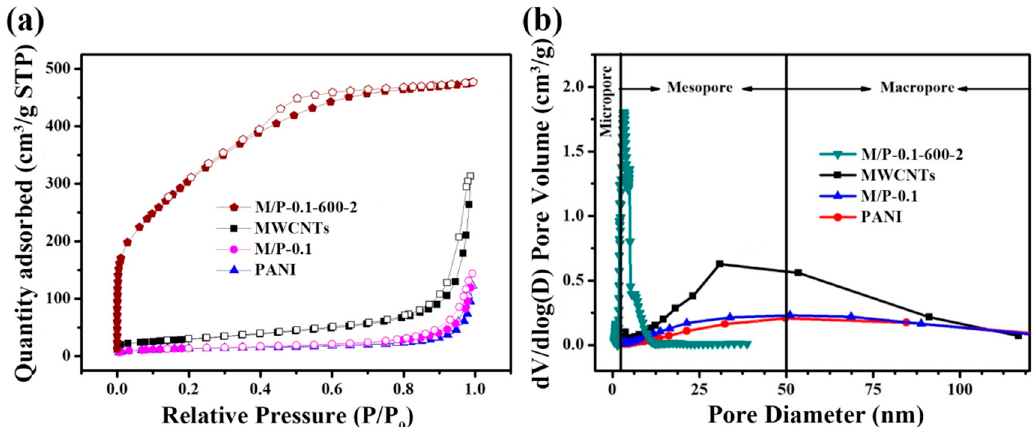
Figure 4. ( a ) N 2 adsorption-desorption isotherms of M/P-0.1-600-2, M/P-0.1, PANI, and MWCNT samples. ( b ) Corresponding pore size distribution profiles.